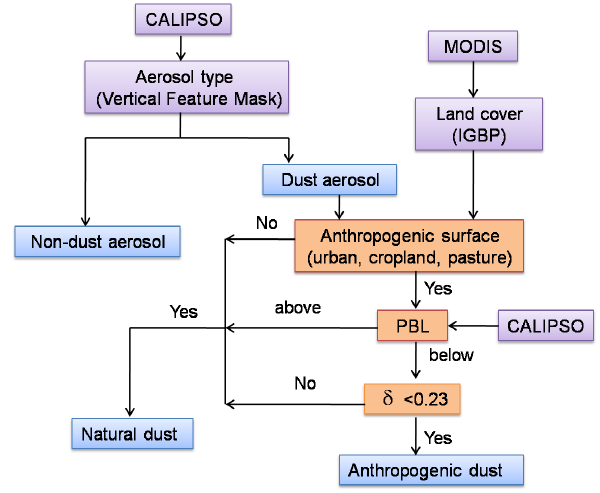
Figure 4. Flow chart of anthropogenic dust detection by combing CALIPSO and land cover data set provided by